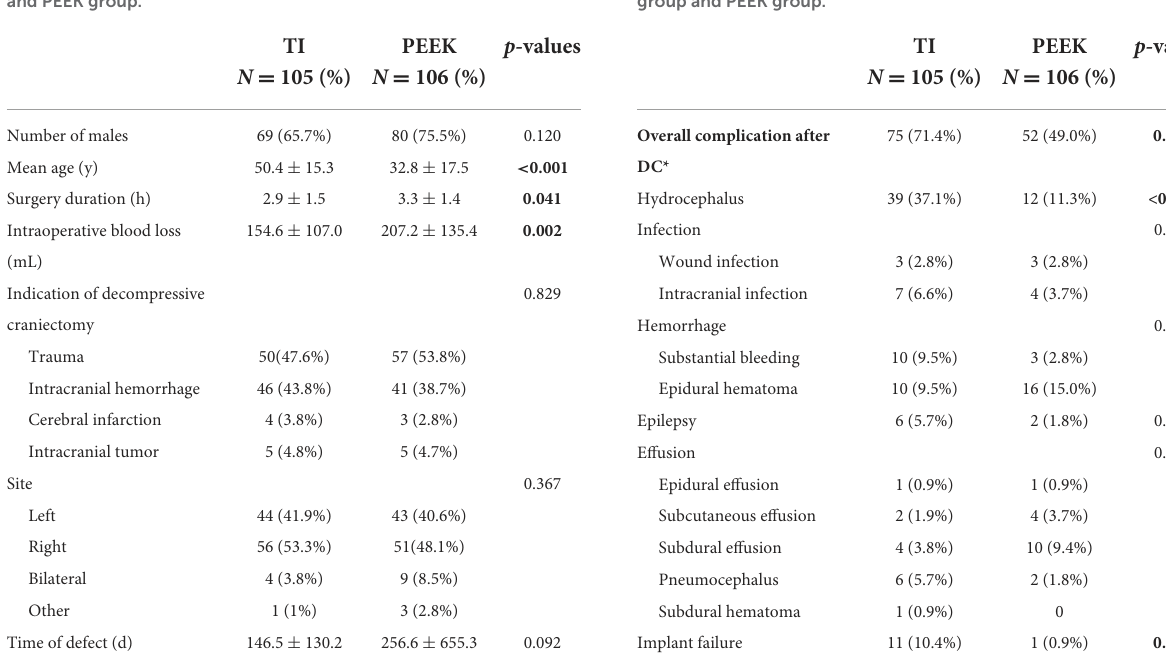
TABLE 1 Patient demographics and characteristics between TI group and PEEK group.